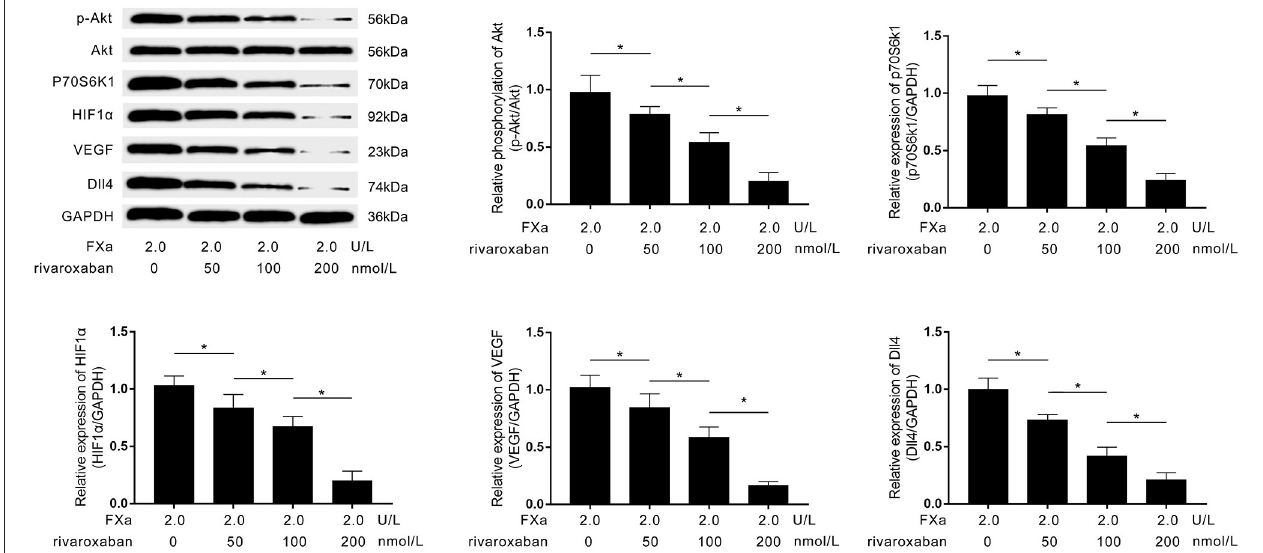
FIGURE 6 | Immunoblots of p-Akt, Akt, p70S6K1, HIF1 α , VEGF, Dll4, and GAPDH are demonstrated. Columns indicate the relative expression levels of HIF1 α , VEGF, and Dll4, as well as the relative phosphorylation level of Akt in macrophages exposed to FXa at 2.0 U/L and treated with rivaroxaban at concentrations of 0, 50, 100, and 200 mmol/L (data were presented as mean ± SD, n = 6, Student’s t -test and ANOVA, * P <